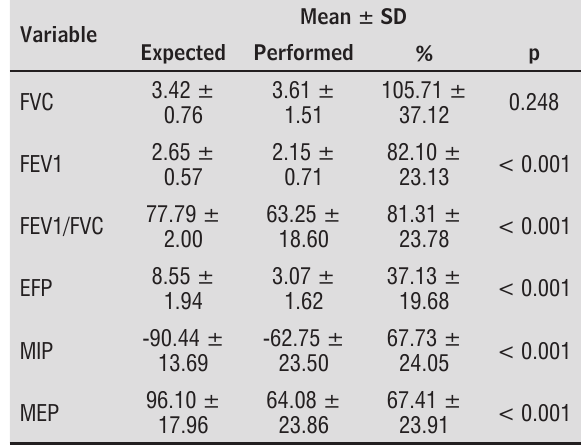
Table 3 - Spirometry and manovacuometry values of elderly patients with PD attended at CREASI in Salvador/BA, 2016